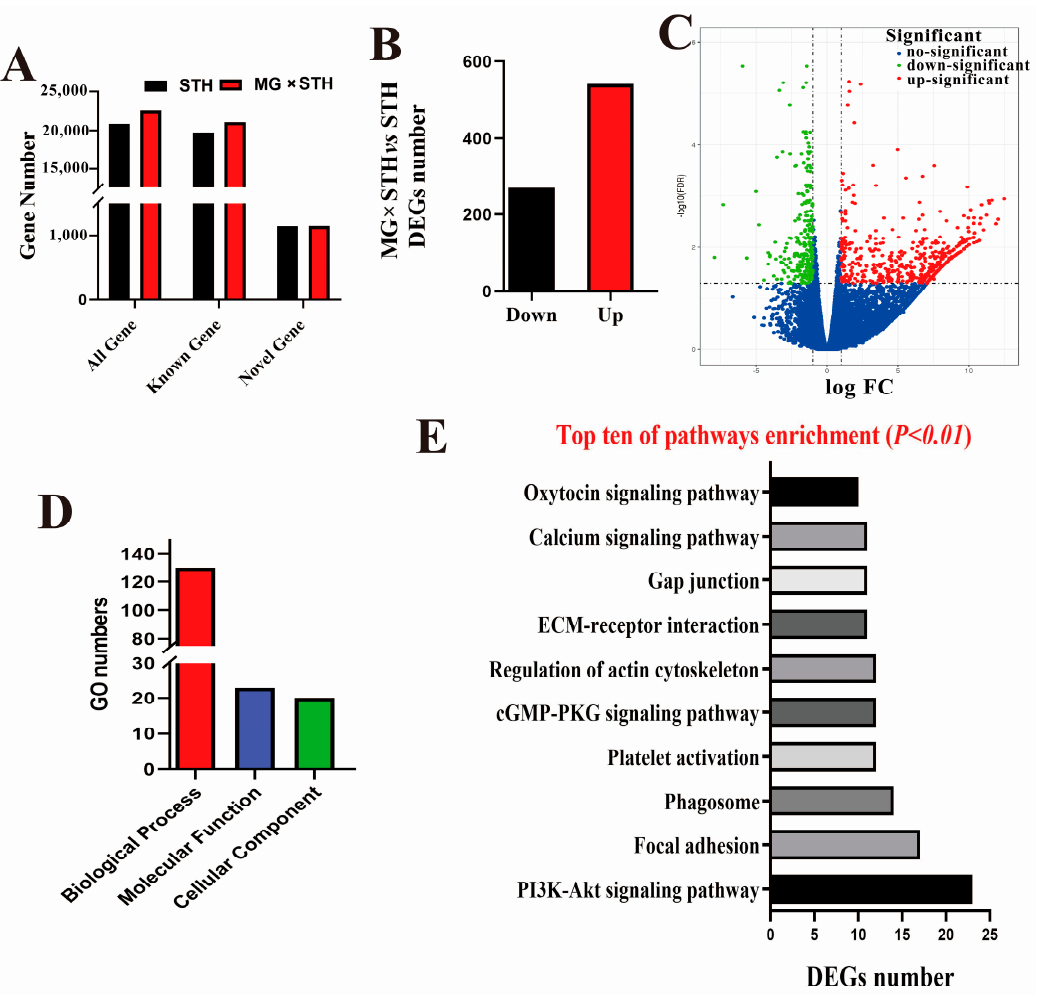
Figure 2. Identity and functional analysis of the differentially expressed genes (DEGs) from longissimus dorsi tissues in the MG × STH and STH sheep. ( A ) Total number of genes identified by transcriptome sequencing in the two sheep groups. ( B ) The number of DEGs compared to the STH sheep. ( C ) Volcano plot of the DEGs. ( D ) The significant gene ontology (GO) numbers of cellular components, molecular functions, and biological processes ( p < 0.05). ( E ) Top 10 most significant pathways according to the DEGs in the two sheep groups ( p < 0.05), where the x axis represents the number of DEGs.